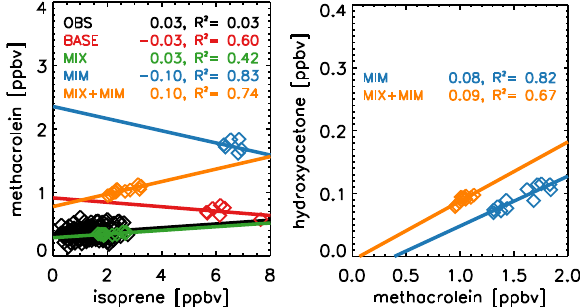
Fig. 9. Measured and modeled correlations between MACR+MVK and isoprene (left), and hydroxyacetone and MACR+MVK (right) at 34m for 5 August 2009 between 11:00–17:00EST. The squared correlation coefficients ( R 2 ) and slopes of the regression lines are given in the upper right-hand corners in colors corresponding to the appropriate model